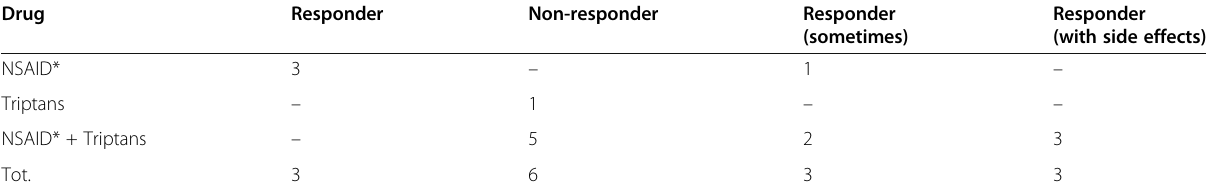
Table 2 Pre- & post-operative drug consumption